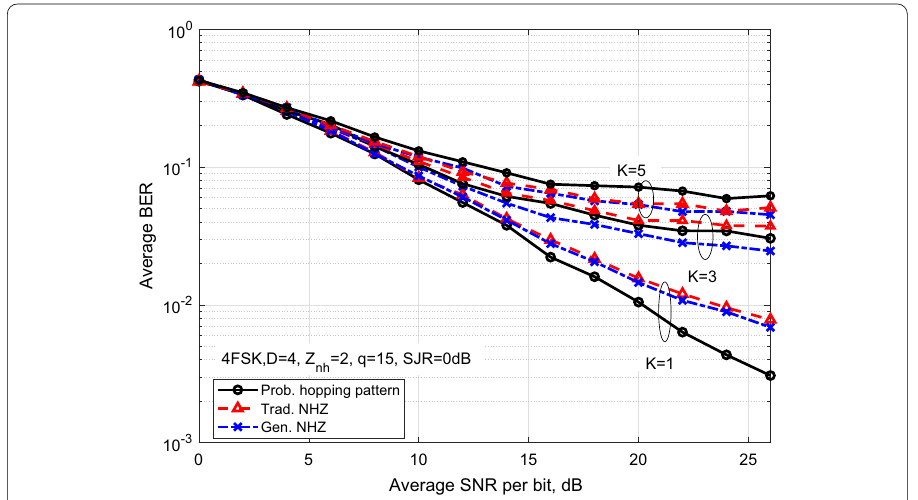
Fig. 4 The BERs of the channel-hopping-based wireless multi-node IoT networks for various number of legitimate users